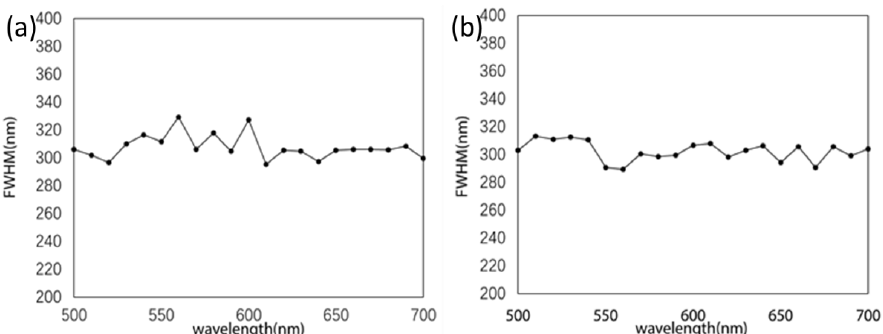
Figure 7. Experimental measurement of FWHM of subwavelength Bessel beam. ( a ) FWHM in the x- direction and ( b ) FWHM in the y- direction.